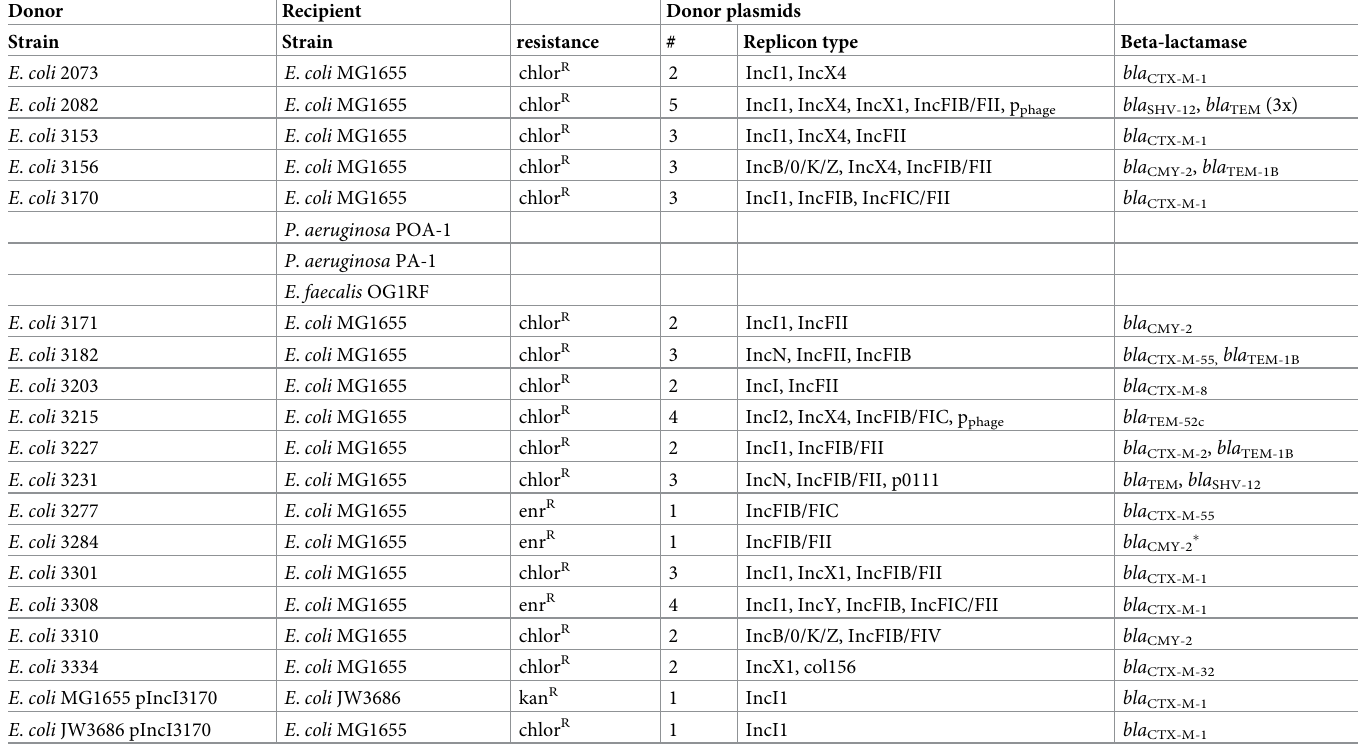
Table 1. List of E . coli strains used as donors, names of recipient strains and their chromosomally encoded antibiotic resistance and characterization of plasmids as found within the donor strains, showing number of plasmids (#), replicon types and beta-lactamase genes. (Sequences can be found at Genbank accession numbers MW390511 to